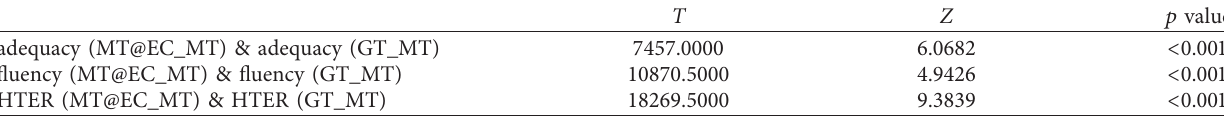
Table 6: Comparison of dependent samples MT@EC output and GT output.